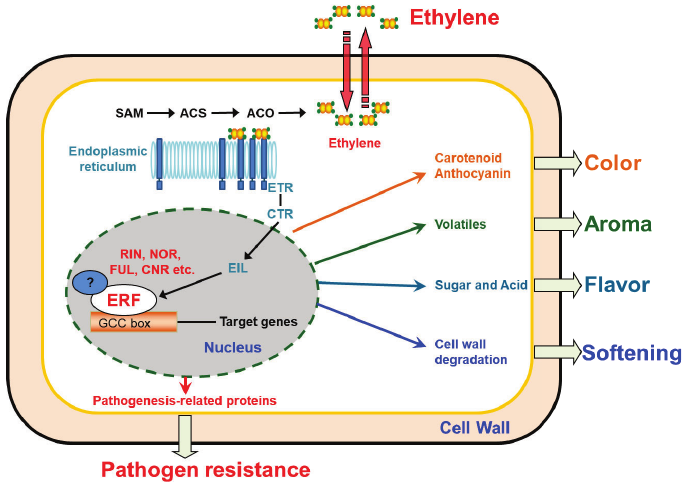
Figure 1. The involvement of ethylene response factor (ERF) in tomato fruit ripening and pathogen response. Ethylene synthesis relies on the activity of ethylene precursor 1-aminocyclopropane-1-carboxylic acid (ACC) synthases (ACS) and ACC oxidases (ACO) which transform S-adenosyl-L-methionine (SAM) into ACC and convert ACC into ethylene, respectively. In tomato, there are 14 ACS (ACS1A, ACS1B, ACS2–13) and 6 ACO (ACO1–6) members; both ACS1A and ACS6 are involved in system 1 ethylene biosynthesis and the autocatalytic ethylene synthesis is catalyzed by ACS2 and ACS4. ACO1 and ACO4 are responsible for the transition to system 2 ethylene because their transcripts accumulate with the climacteric rise of ethylene production [32]. The ERFs function downstream of the ethylene signaling chain (ethylene receptors (ETR), constitutive triple- response (CTR), EIN3-Like (EIL)), and play roles in fruit color, aroma and flavor formation, softening changes and pathogen resistance by regulating different facets of the ripening response by binding to target gene GCC-box elements and transactivation promoters of genes involved in accumulation of carotenoid or anthocyanin and volatiles, sugar and acid metabolism, cell-wall degradation and pathogen response. Ripening regulators such as MADS-RIN (RIN), SBP-CNR (CNR) and NAC-NOR (NOR) also act on expression of multiple downstream target